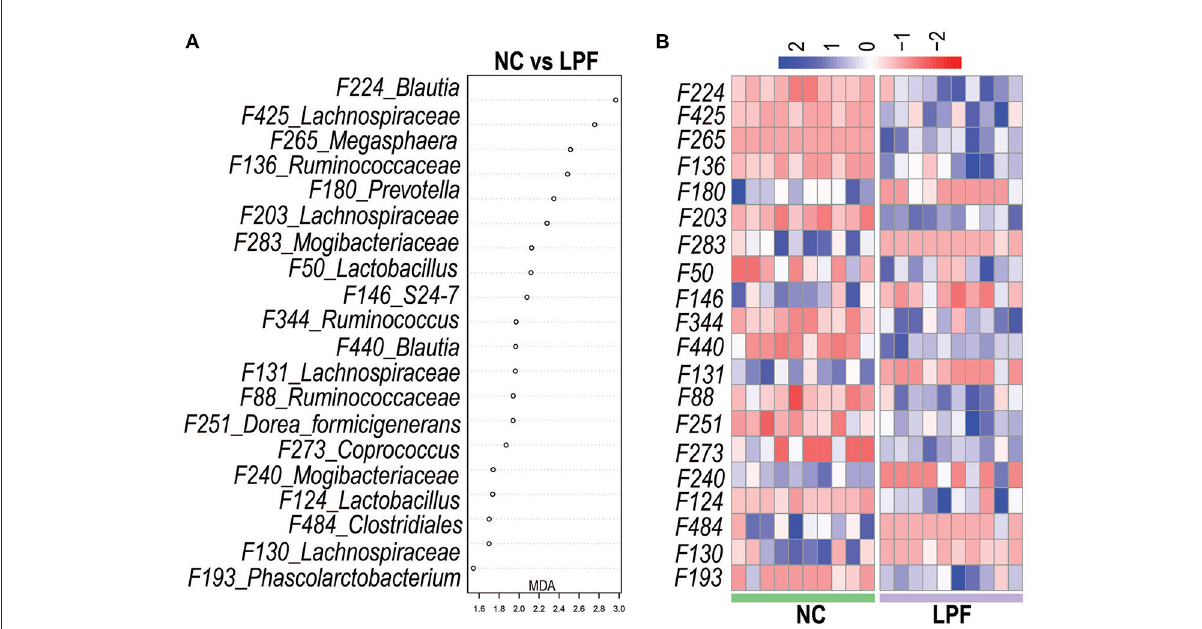
FIGURE6 Gut microbiota signature of the pigs fed with LPF diet was determined by Random Forest. (A) Top 20 most predictive features that differentiate LPF-fed pigs from those fed with NC diet. (B) Heatmap shows the relative abundance of Features (log 10 transformed) selected by Random Forest. NC diet: basal diet, LPF diet: NC + 10% Lactobacillus plantarum and Pediococcus acidilactici co-fermented